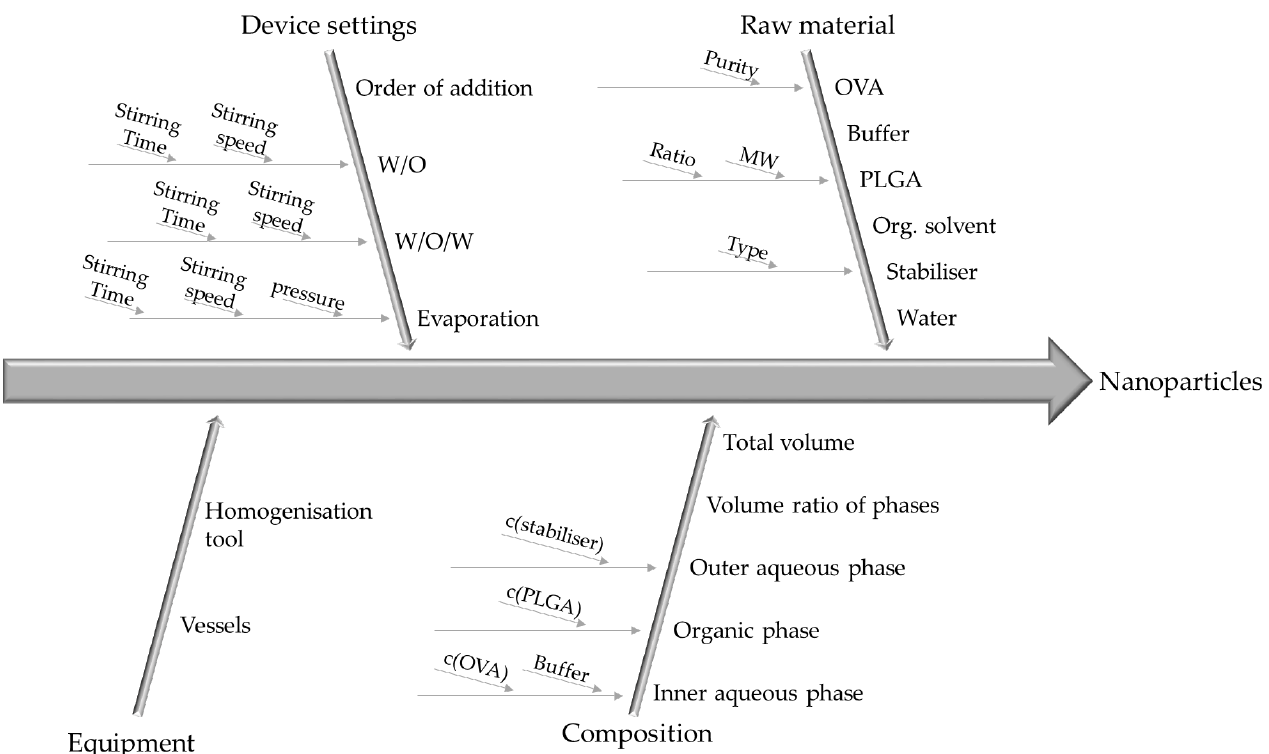
Figure 1. Fishbone (Cause-and-effect) diagram of process parameters, which potentially have an influence on the defined outcomes. influence on the defined